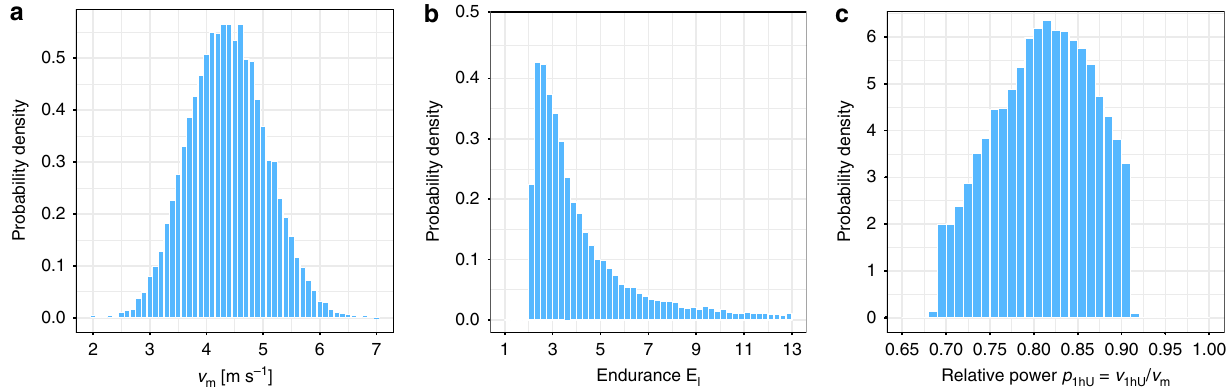
Fig. 2 Probability density of model parameters. The crossover velocity v m which is the smallest velocity that elicits maximal aerobic power MAP and the endurance E l are obtained by applying our model to the fastest performances of a subject for the four distances 5 km, 10 km, Halfmarathon, and Marathon of a racing season. For these distributions, a total of 24,858 racing seasons have been analyzed. a The velocity v m is approximately normally distributed with a mean of 4.4 m s − 1 . b The probability density for the endurance E l resembles an exponential decay. c The probability density for the relative power for 1h utilization (1hU) peaks at about 82% of MAP.